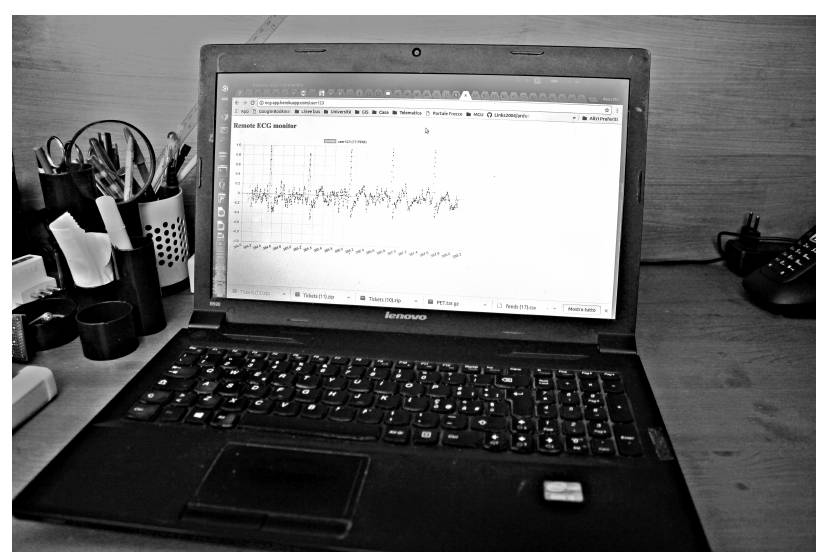
Figure 4. The remote ECG display on the doctor’s